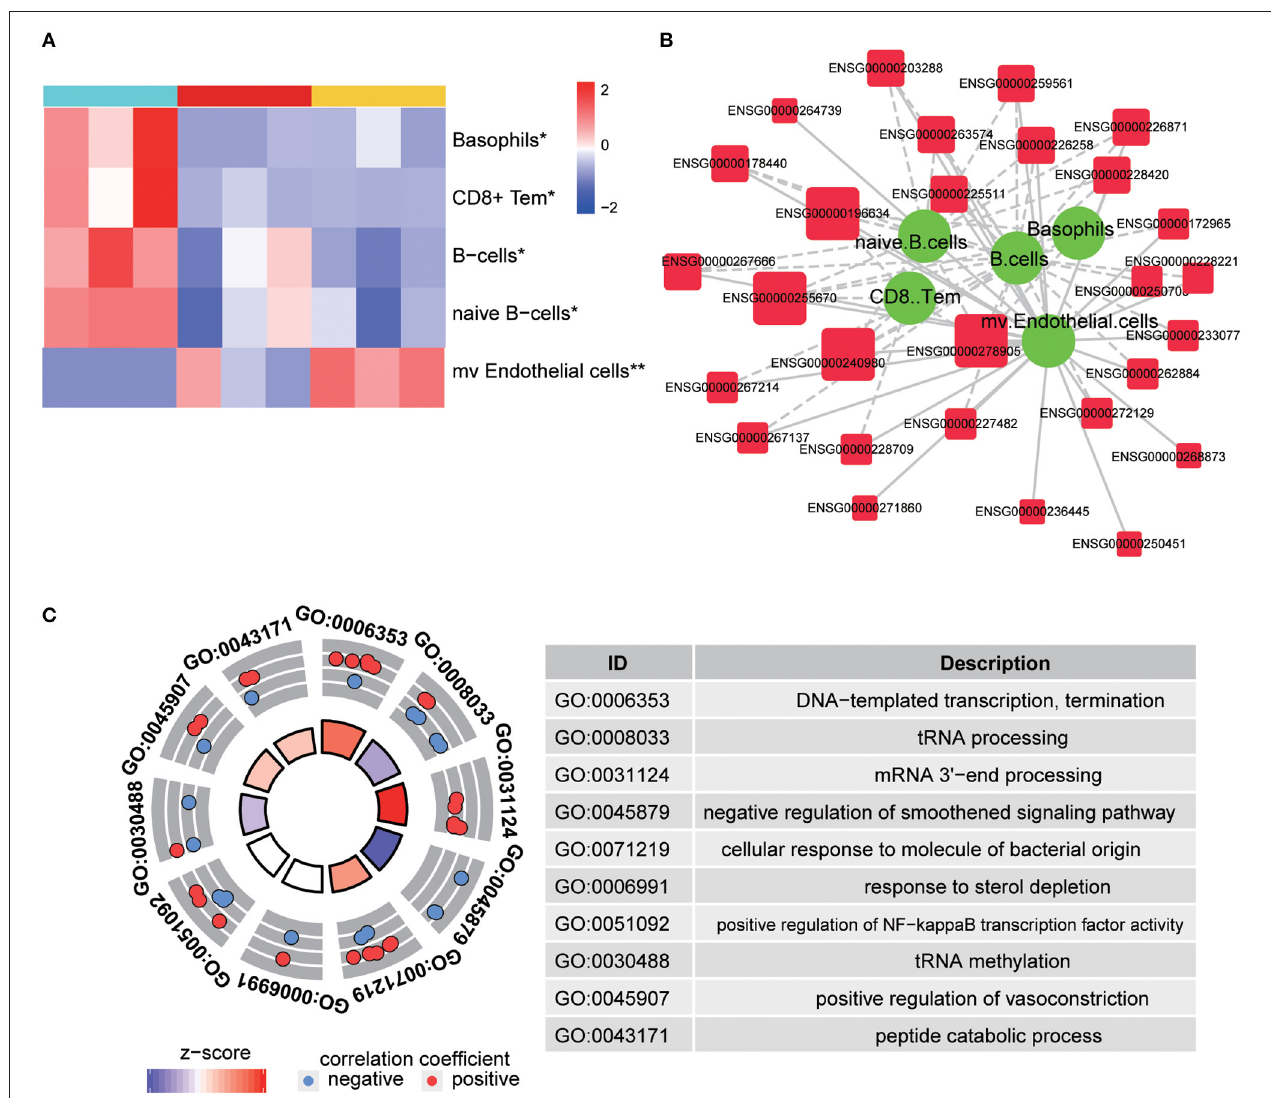
FIGURE 4 | Predicted cellular behavior. (A) Representative heatmap is shown to predict significantly changed cellular behaviors in each group. P -values were obtained via one-way ANOVA; * and ** indicate P -value < 0.05 and P -value < 0.01, respectively. CD8 + Tem, CD8 + effector memory T-cells; mv endothelial cells, microvascular endothelial cells. (B) Representative image of interactions between identified long non-coding RNA (lncRNA) and changed cellular behavior. The larger size of lncRNA node indicates that more types of changed cellular behavior correlated with it. The thickness of a line represents the correlation coefficient. Solid and dotted lines showed the positive and negative relationships between the expression and changed cellular behavior, respectively. (C) Gene Ontology (GO) enrichment analysis of changed cellular behavior related to lncRNAs. The outer circle shows a scatter plot for each term of the correlation coefficient of the assigned target genes, and the z -score shows the number of positive genes minus the number of negative genes divided by the square root of the